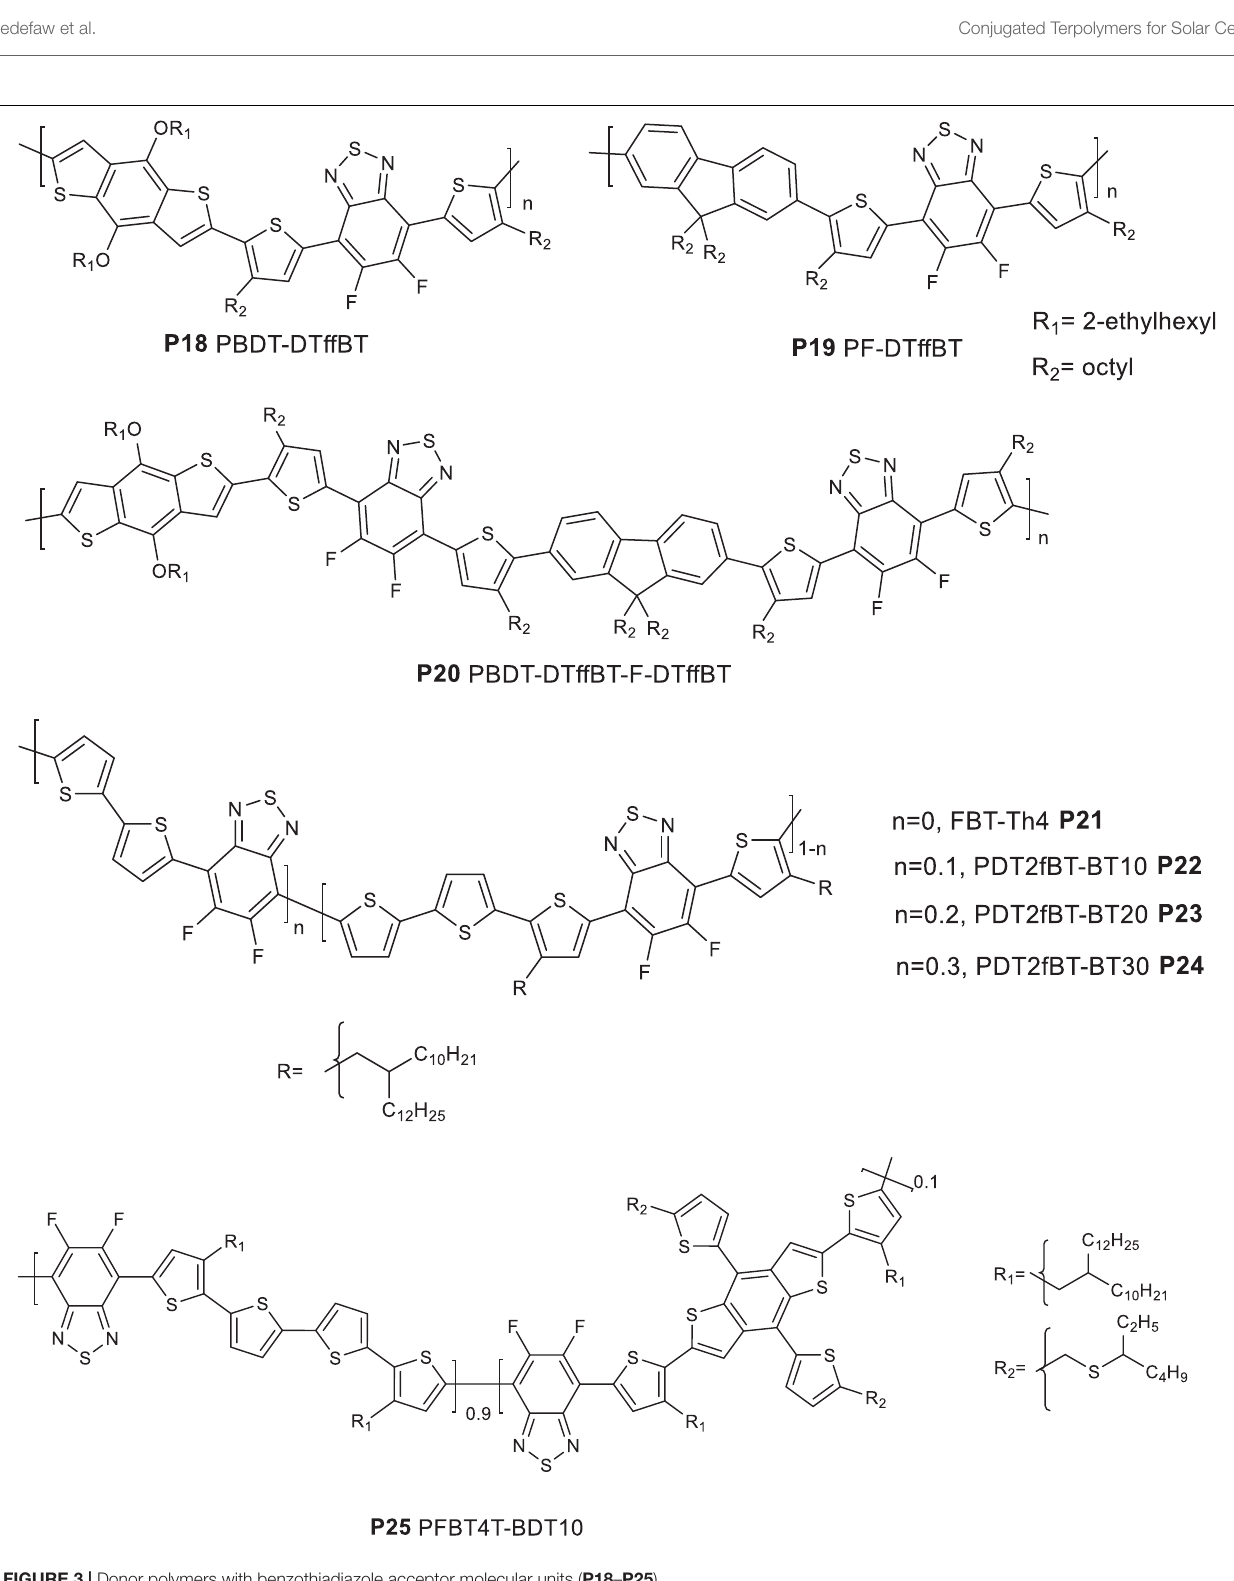
the molecular energy level and optical absorption were